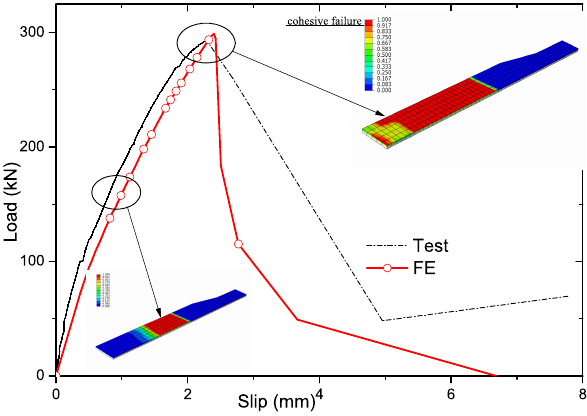
Figure 11. Verification of sand-coated specimens’ FE model.